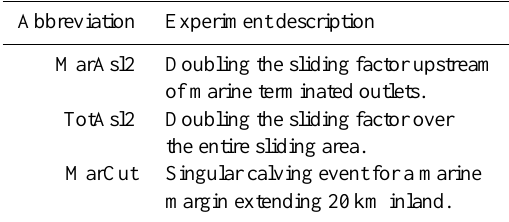
Table 3. Overview of the three perturbation